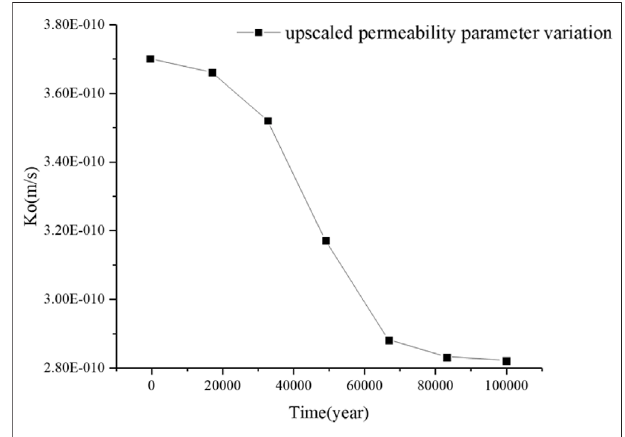
FIGURE 11 | lot of upscaled permeability k o changes with respect to time.